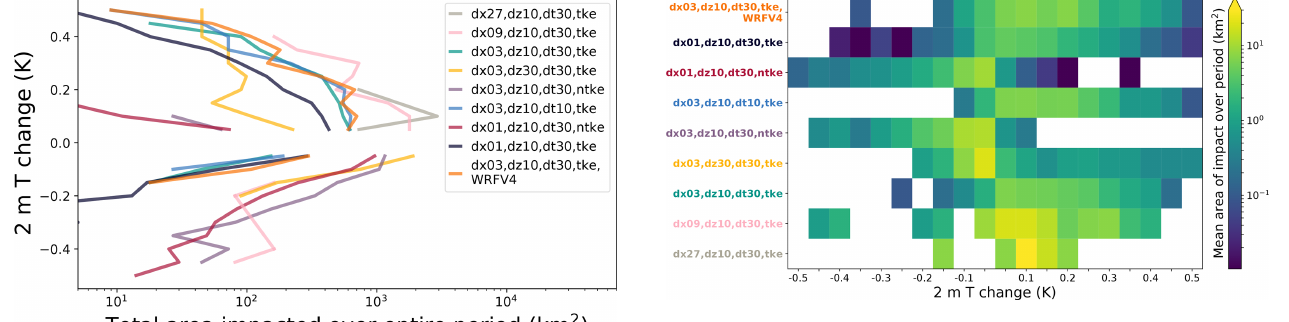
Figure 14. Average area affected by each 2m temperature change (columns) over the entire simulation period for each simulation tested (rows). Yellow squares indicate larger areas of impact, with empty (white) squares indicating a lack of occurrence for that par- ticular magnitude of